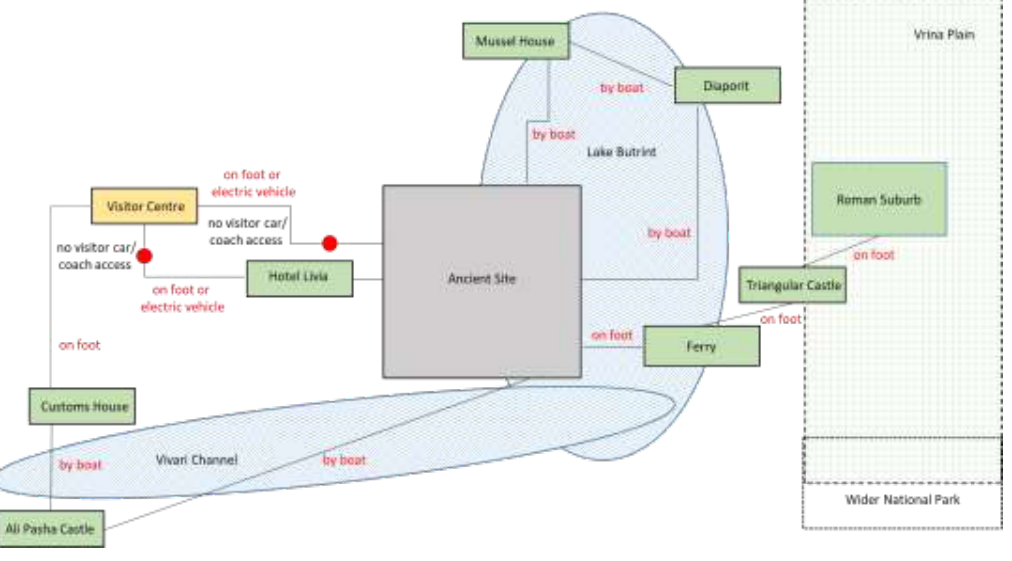
Figure 13: Wider site opportunities and transport